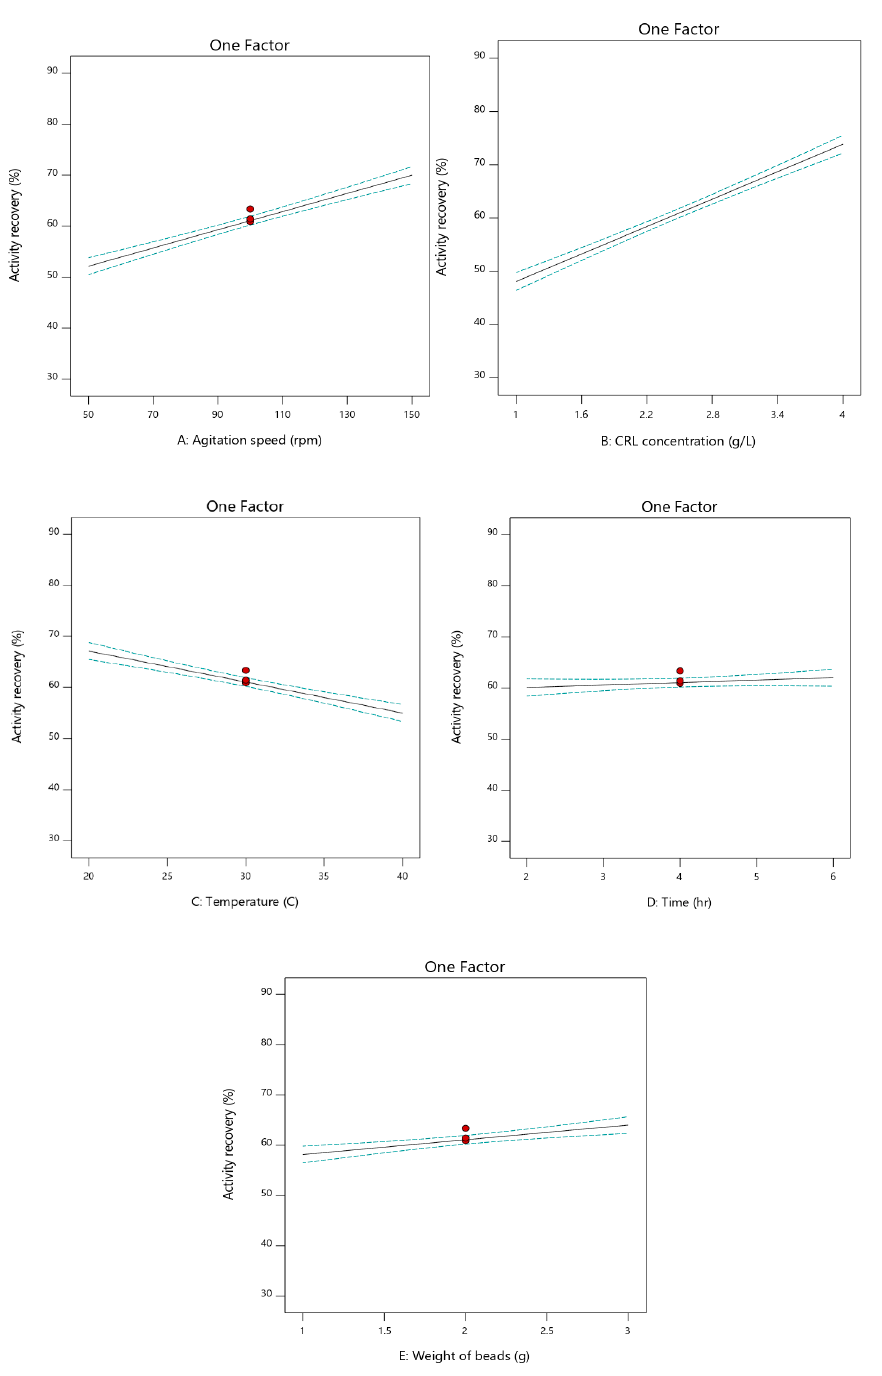
Figure 3. One-factor effect of five independent variables: ( A ) agitation speed, ( B ) CRL concentration (g/L), ( C ) temperature, ( D ) time, and ( E ) weight of MgO-Al 2 O 3 beads towards activity recovery.